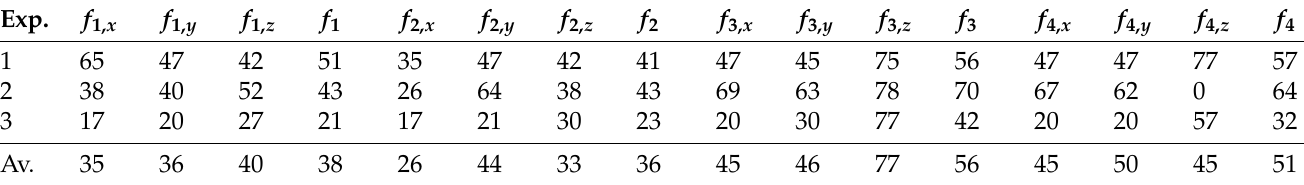
Table 3. ET frequency reduction rates during the Prototype (A) Open-Loop evaluation.